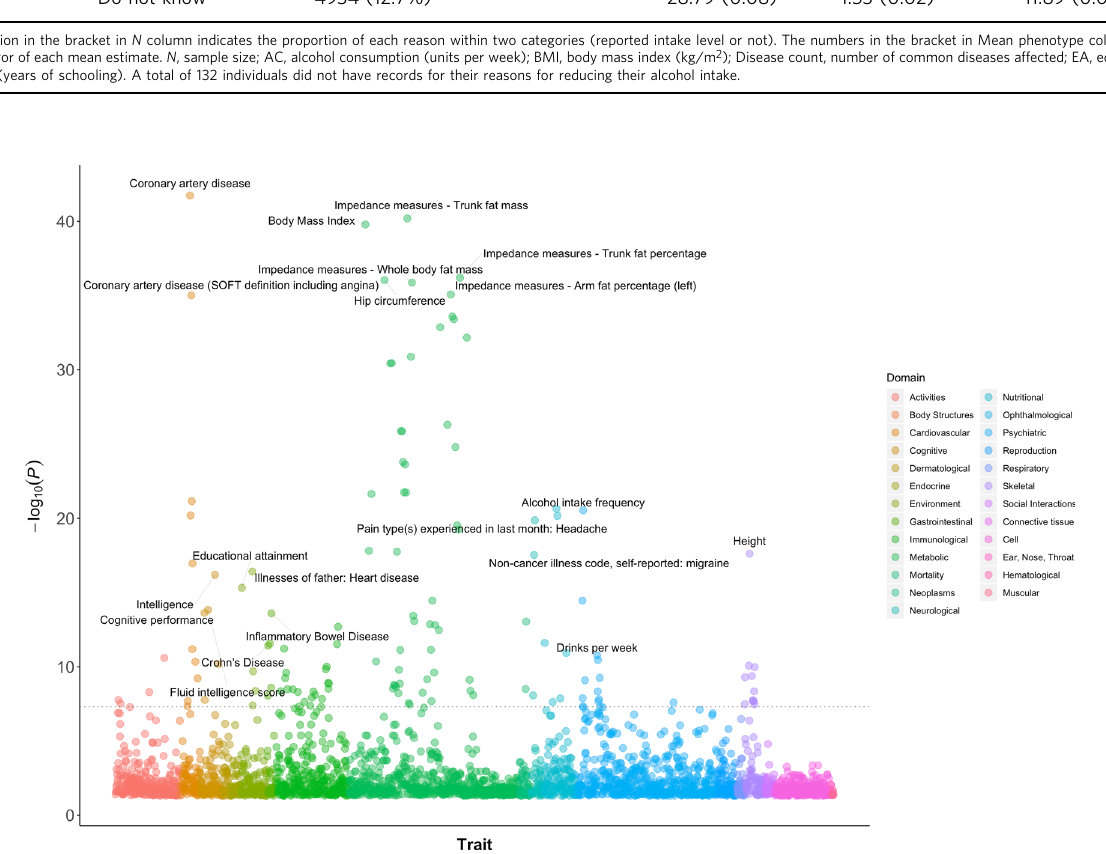
Fig. 1 PheWAS results for the 16 AC GWAS signals that became non-signi fi cant after the MLC corrections. This fi gure shows associations of the AC- associated variants, which became non-signi fi cant because of the MLC corrections, with all the common traits and diseases for which summary data from large-scale GWASs are available in the public domain (https://atlas.ctglab.nl/PheWAS). The colour denotes the domain of each associated trait. There were 136 traits associated with the 16 SNPs with P < 5 ´ 10 (cid:1) 8 , and 61 (44.9%) of them were metabolic/cardiovascular